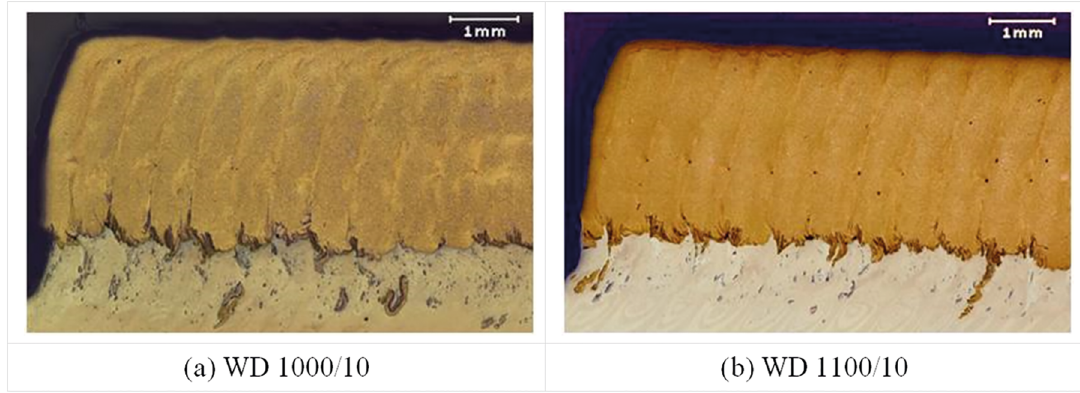
Figure 11. Stir bands in samples produced with high energy